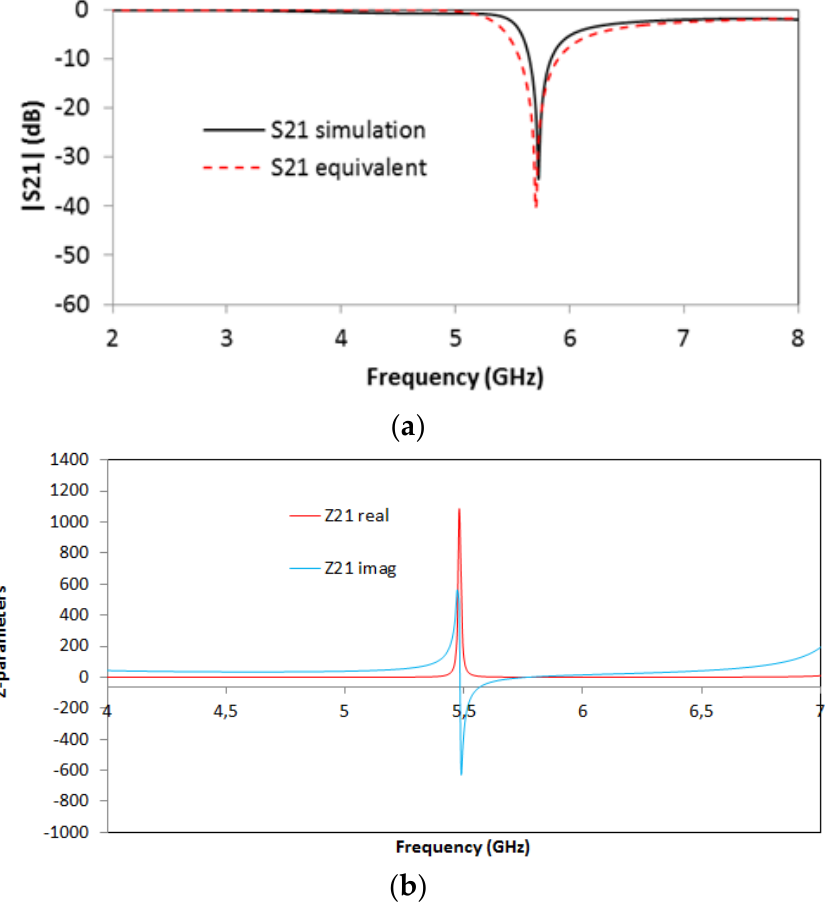
Figure 6. ( a ) Simulated S21 (solid black line) and simulated S21 for the equivalent circuit model (dashed red line). ( b ) Impedance graph: Z21 real part (solid red line) and Z21 imaginary part (solid blue line).